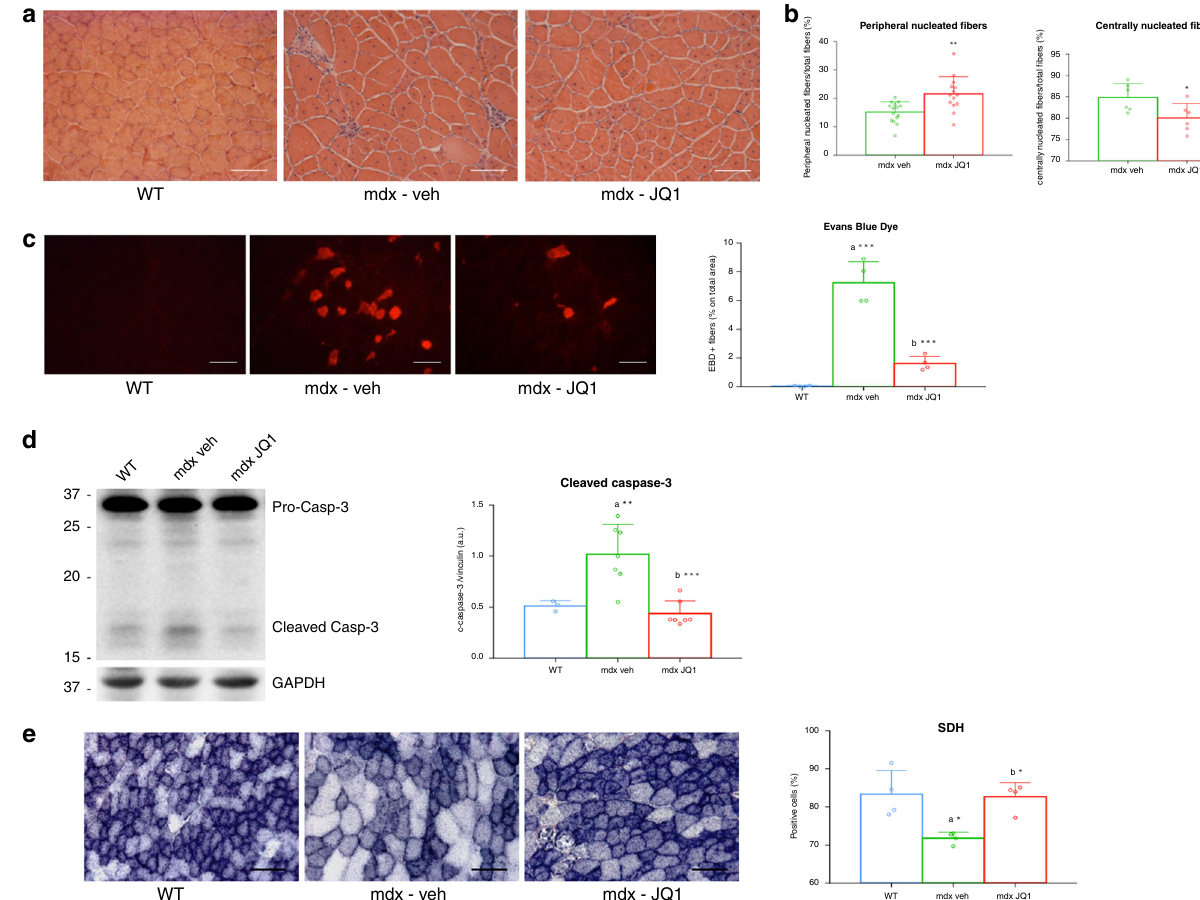
Fig. 2 JQ1 treatment leads to morphological improvements in mdx mice. a Hematoxylin/Eosin staining of TA muscles from JQ1- and vehicle-treated mdx mice. JQ1 was chronically administered for two weeks. Scale bar: 50 µ m. b JQ1 treatment increases the number of intact fi bers in mdx TAs. Data are expressed as the mean ± SD, n = 3 animals, * P < 0.05 and ** P < 0.01 was determined by using unpaired two-sided t -test. Total fi bers and percentage of peripheral ( n = 15 sections examined from n = 3 animals for each experimental group) and centrally nucleated ( n = 6 sections examined from n = 3 animals for each experimental group) fi bers per area were evaluated from Hematoxylin/Eosin staining of TA muscles ( n = 3 for each experimental group). c JQ1 treatment strongly decreases the number of damaged myo fi bers, as observed by the decreased uptake of Evans blue dye from TA mdx muscles ( n = 4 for each experimental group). Scale bar: 50 µ m. ***denotes P < 0.001 and was determined by 1 way-Anova followed by Tukey ’ s post hoc test. d Immunoblot showing pro-Caspase-3 and cleaved Caspase-3 in TAs from control, vehicle-, and JQ1-treated mice. Right panel: quanti fi cation of band intensity was performed with ImageJ. Data are expressed as the mean ± SD, n = 7 animals for mdx groups, n = 3 animals for WT. ** P < 0.01 and *** P < 0.001 were determined by using one-way ANOVA followed by Tukey ’ s post hoc test. a indicates statistical signi fi cance compared to Control group; b indicates statistical signi fi cance compared to the mdx mice animal group. e SDH staining from muscle deep region of TAs, from control, vehicle- and JQ1- treated mice. Scale bar: 50 µ m. Right panel: quanti fi cation of SDH staining intensity. Data are expressed as the mean ± SD, n = 4 animals per group. a and b as de fi ned in (d). *Denotes P < 0.05 and was determined by 1 way-Anova followed by Tukey ’ s post hoc